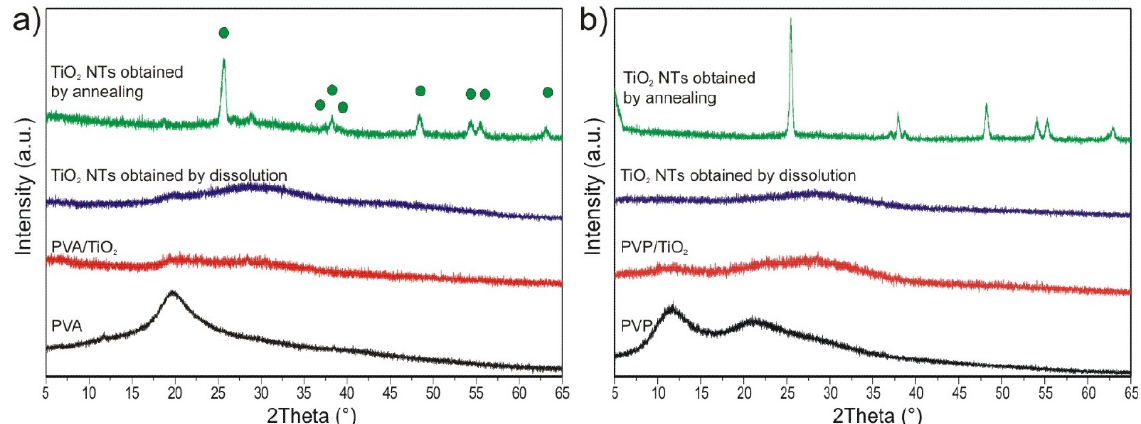
Figure 5. XRD patterns of the samples prepared from ( a ) PVA, ( b ) PVP (The anatase peaks have been now marked with green circles).